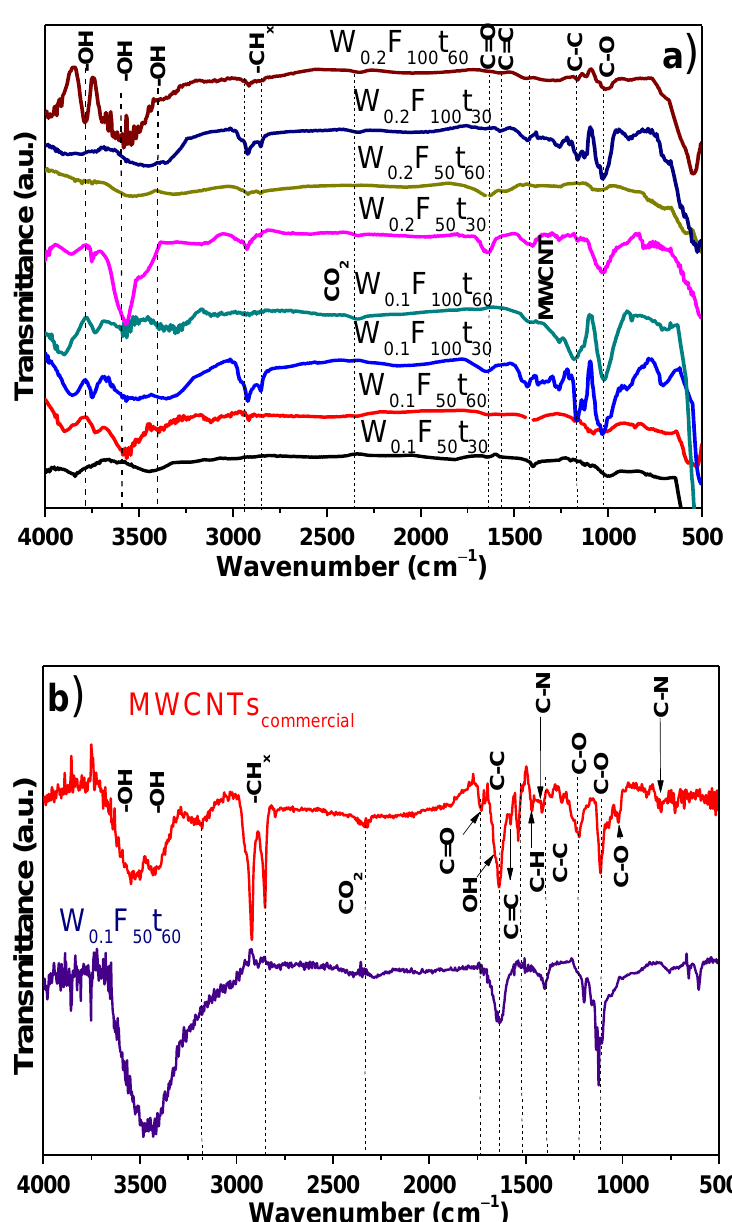
Figure 2. FT-IR spectra from MWCNTs at 850 °C, after purification with 3 M HCl + 30 vol.% H 2 O 2 : ( a ) samples at different conditions; ( b ) comparison between commercial MWCNTs and a selected sample.